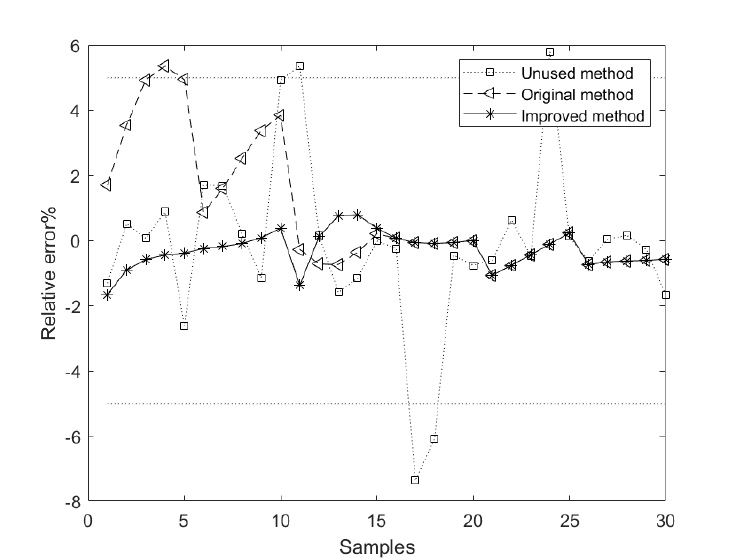
Figure 5. Forecast relative error of different